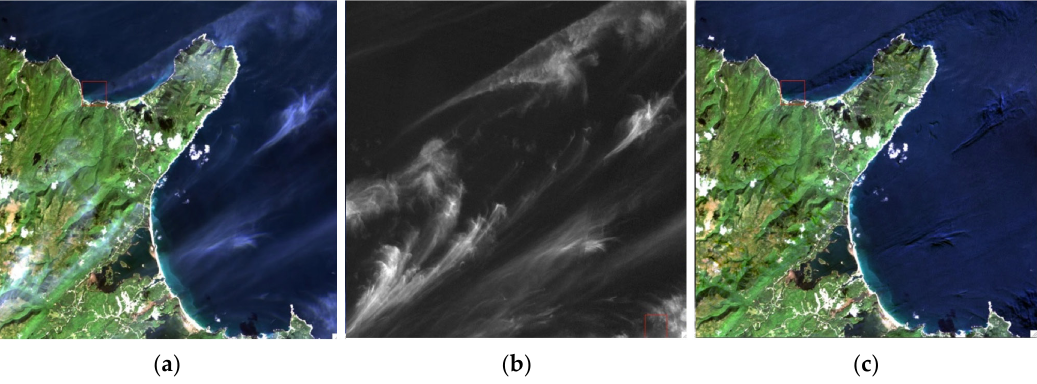
Figure 1. ( a ) A Landsat 8 Operational Land Imager (OLI) RGB image acquired over Cape Breton Island in eastern Canada (northeast to Halifax) on 16 September 2014; ( b ) The corresponding Band 9 (cirrus band) image; and ( c ) The cirrus-corrected RGB